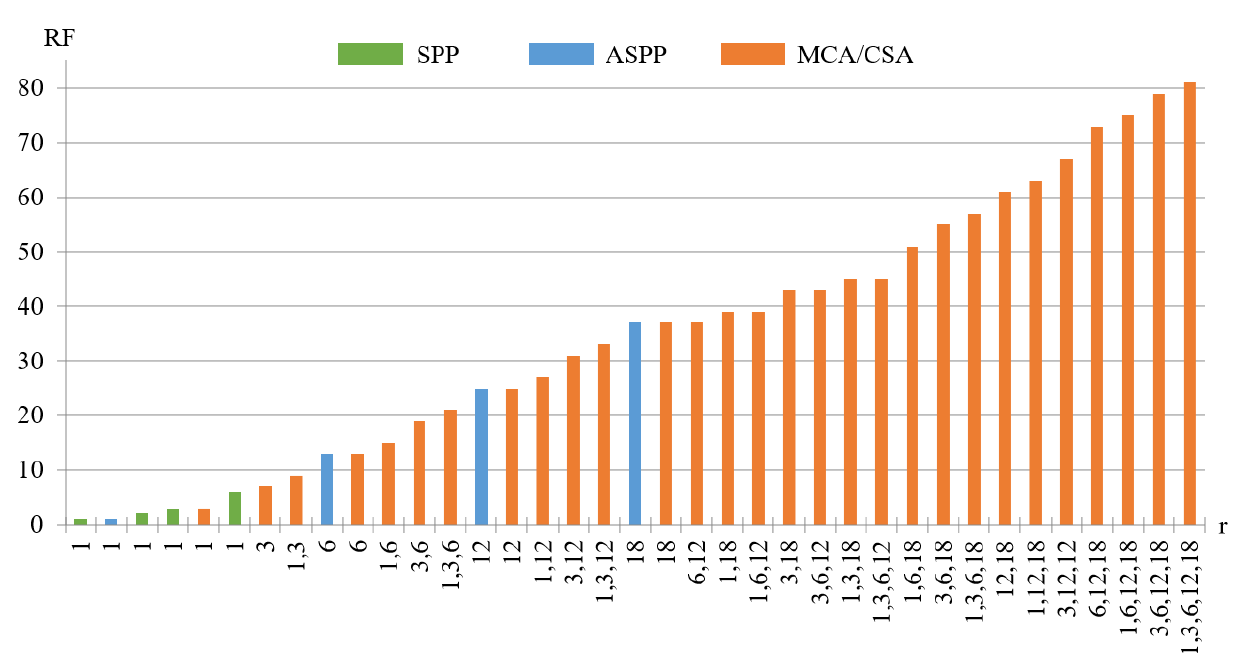
Figure 7. Comparison of the receptive fields corresponding to SPP, ASPP, MCA and proposed cross-scale semantic aggregation module (CSA) with different combinations of dilated convolutions. Note that only the receptive fields with different combinations of dilated convolutions are listed in the bar